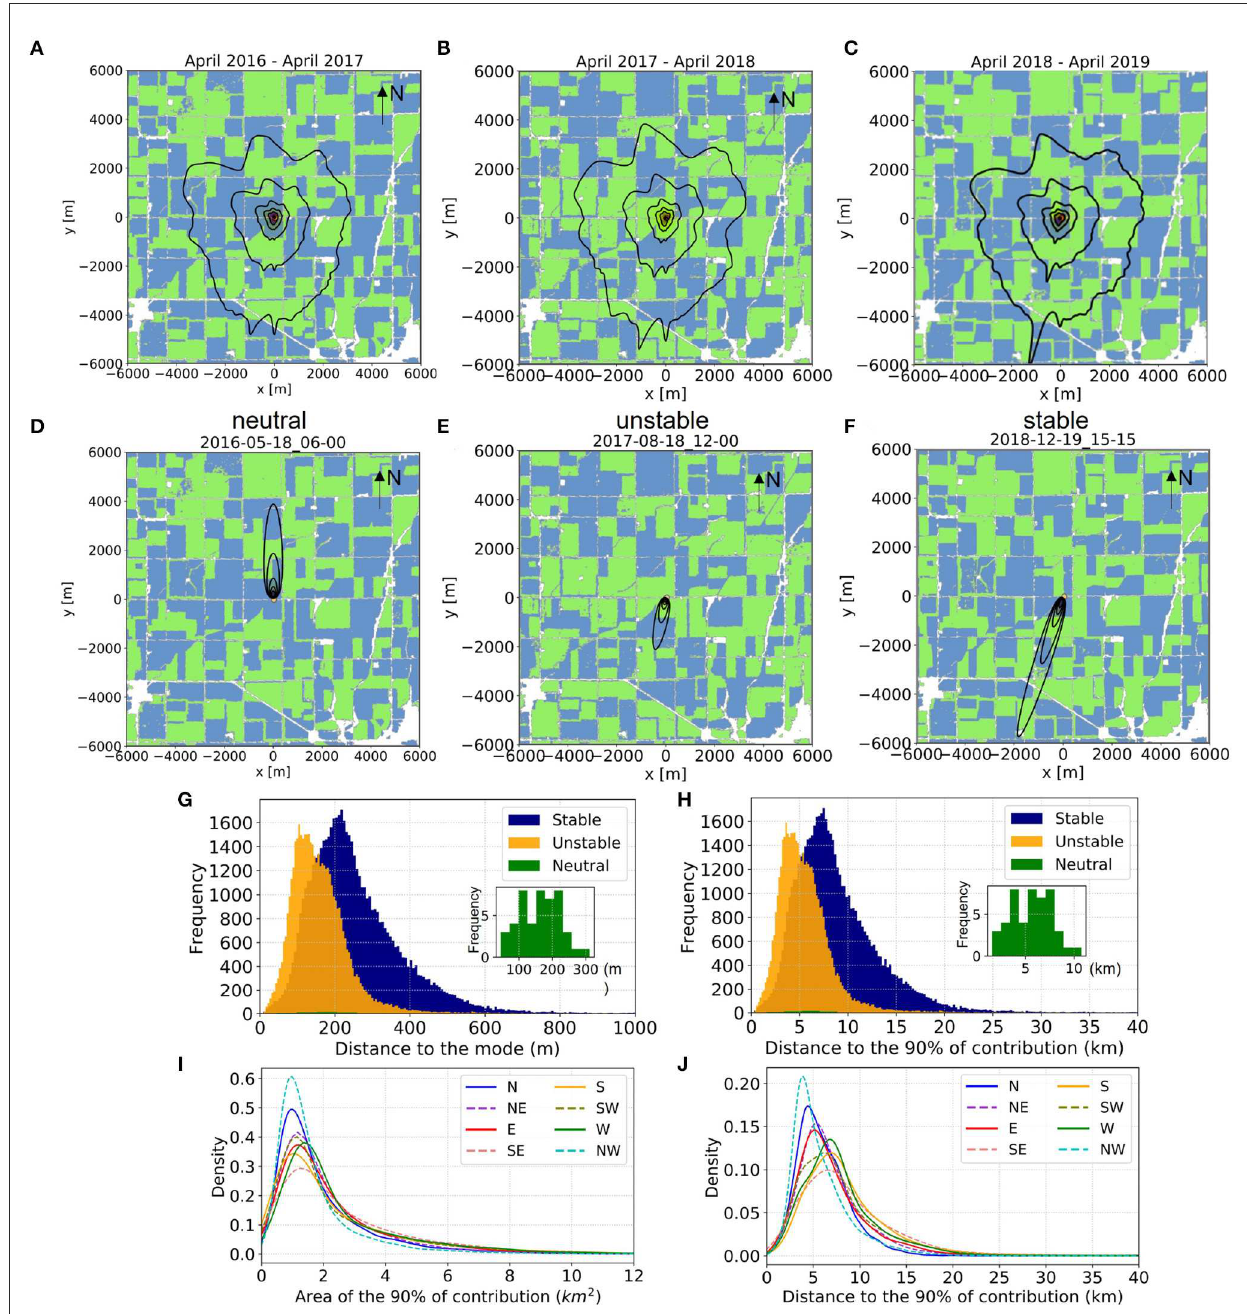
FIGURE5 Flux footprint plots with contours over the mosaic of maize (blue) and soybean (green) crops with the center at the flux tower. Each flux footprint plot shows the source area defined by the contours of 20, 40, 60, 80, and 90% (outer contour) of the total flux contribution. The climatological (or average) flux footprint for crop years (A) 2016 (i.e., April 2016 to March 2017), (B) 2017, and (C) 2018, correspond to the aggregation of all single footprints over the year. A sample of single 15-minutes averaged flux footprints under (D) neutral (05/18/2016 06:00), (E) unstable (08/18/2017 12:00), and (F) stable (12/19/2018 15:15) atmospheric conditions show the changes in size and location of the source area of the surface flux defined by the dynamic flux footprint. Histograms of the 15-min FFP analysis for the upwind distance (fetch) to the (G) mode and to the (H) 90% of flux contribution, illustrate the average behavior under stable (blue), unstable (orange), and neutral (green) atmospheric conditions over the 3 years of analysis. The probability density function of the upwind (I) area and (J) distance of the 90% of flux contribution show differences based on wind